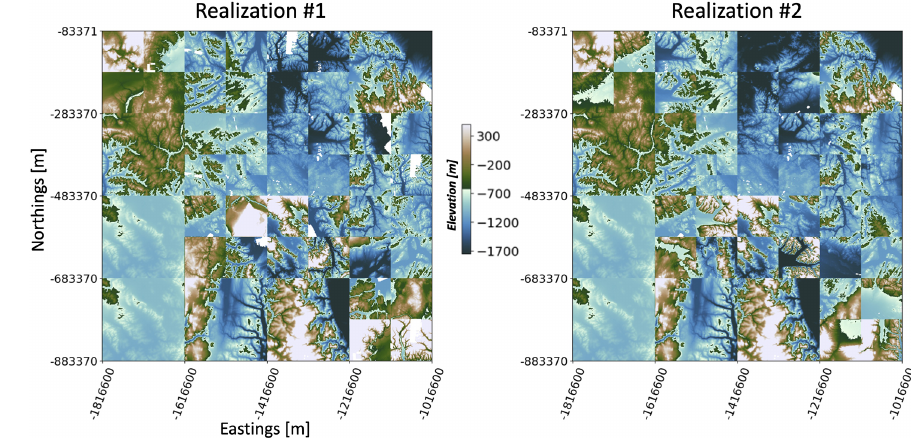
Figure 17. Two realizations of TIs assigned to the entire ASE area.